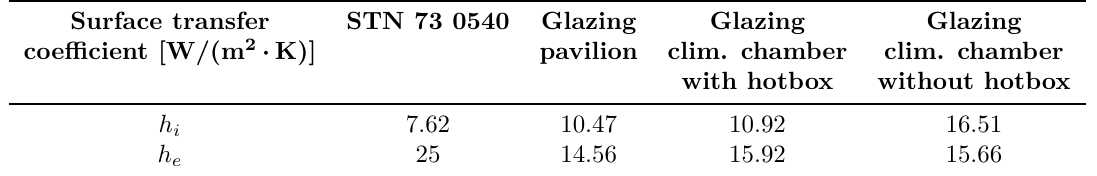
Table 2. The surface transfer coefficient is defined in STN 73 0540 and calculated using Equations (2) and (3).